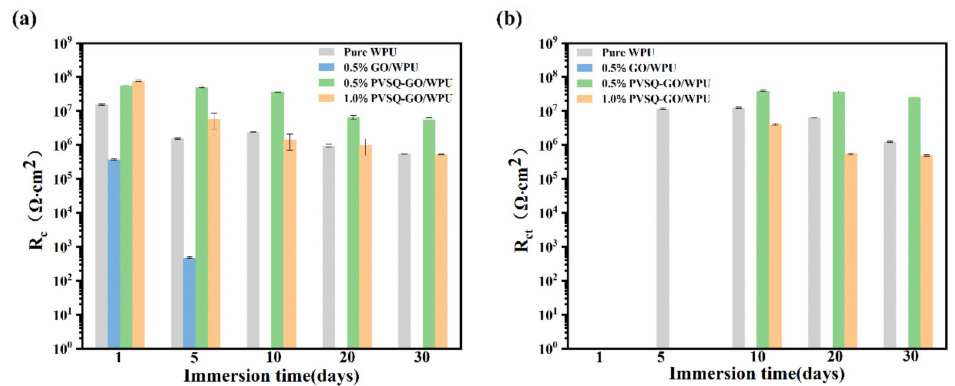
Figure 12. Variation of the electrical parameters ( a ) R c , ( b ) R ct obtained from the fitting results for di ff erent coating systems at various immersion times under 3.5% NaCl